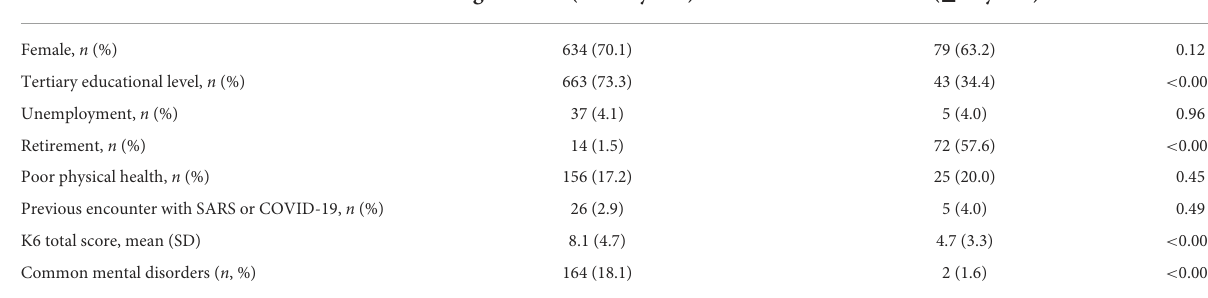
TABLE 1 Comparison of characteristics between younger and older adults ( n =